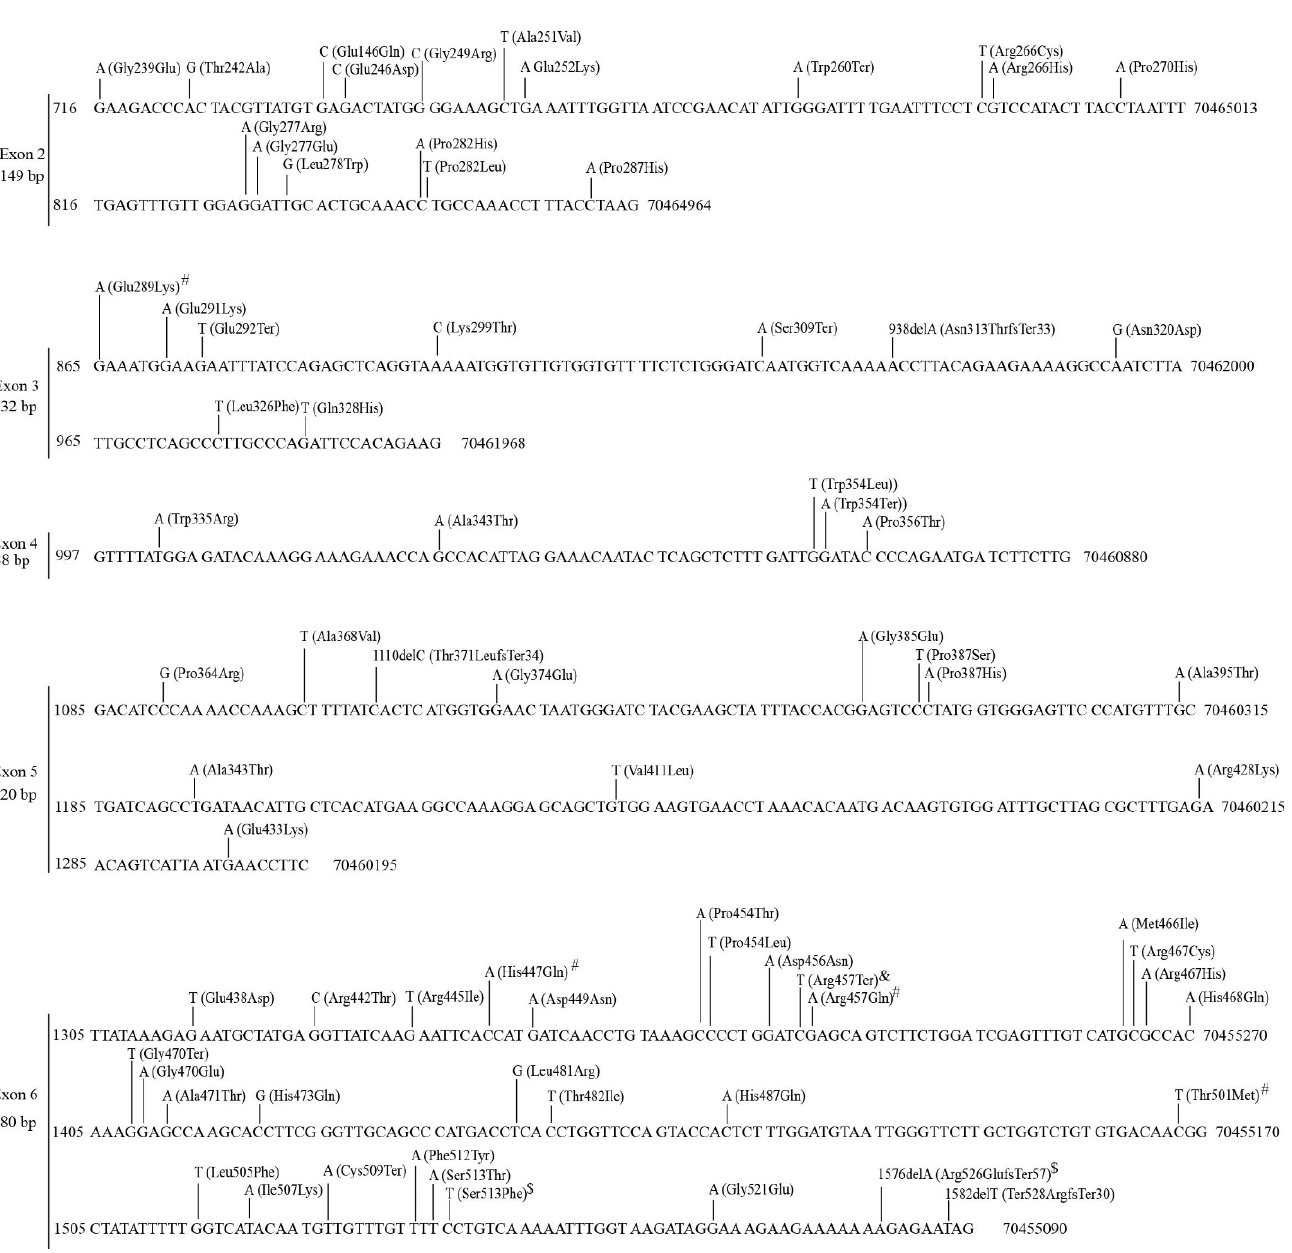
Figure 4. Mutations within the shared UGT2A1/UGT2A2 exons 2–6 in TCGA tumors. Data shown are the NCBI reference sequence (5 exons, 869 bp) for UGT2A1/2A2 exons 2–6 with genomic (GRCh37/hg19, right) and cDNA (NM_006798.5, left) positions. Mutations (missense, nonsense and small indels) and the resulting changes at the protein level (NP_006789.3) are indicated above the reference sequence. Recurrent mutations are indicated by # (twice), $ (three times) and & (five